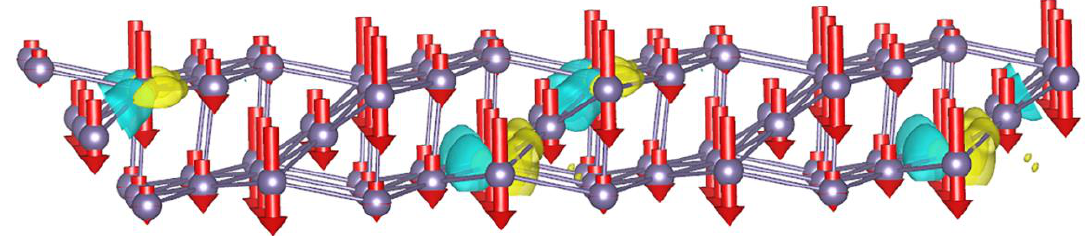
Figure 2. The localization of hole states (one hole) in the germanium with quantum state |1>, with a spin down direction s = − 1, is the most energetically advantageous state by 0.72 µ eV compared with the state |0>, with a spin up s = +1. The directions of the downward spins s = − 1 are indicated by red arrows.